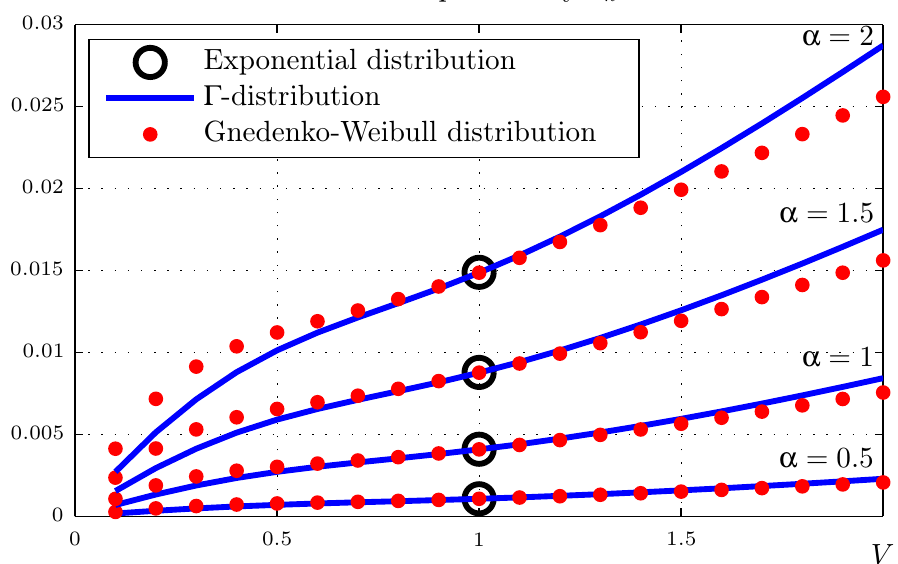
Figure 4. Probabilities of the compressor shop failure (“2-out-of-4”) for b = 5 days, g = 10